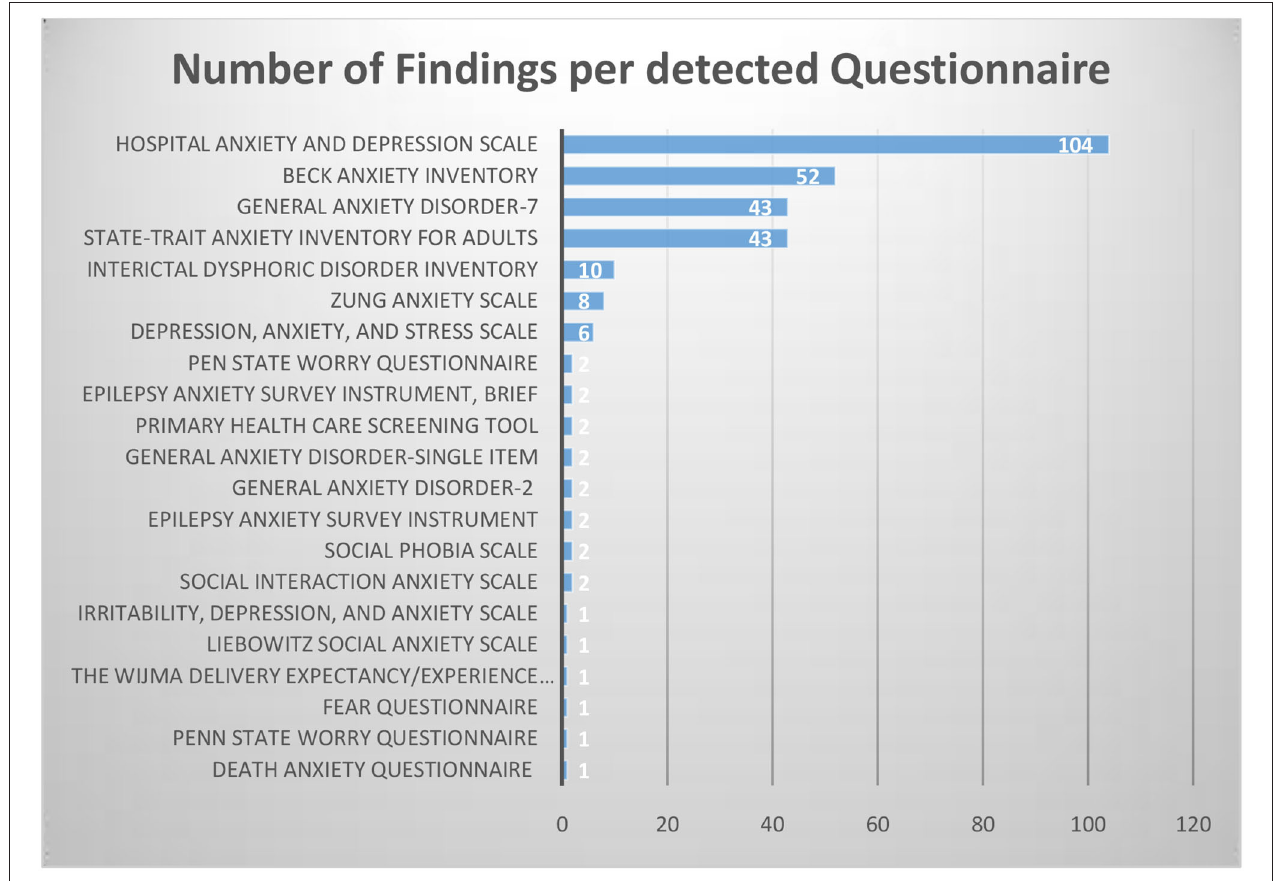
FIGURE 2 | Number of detections per